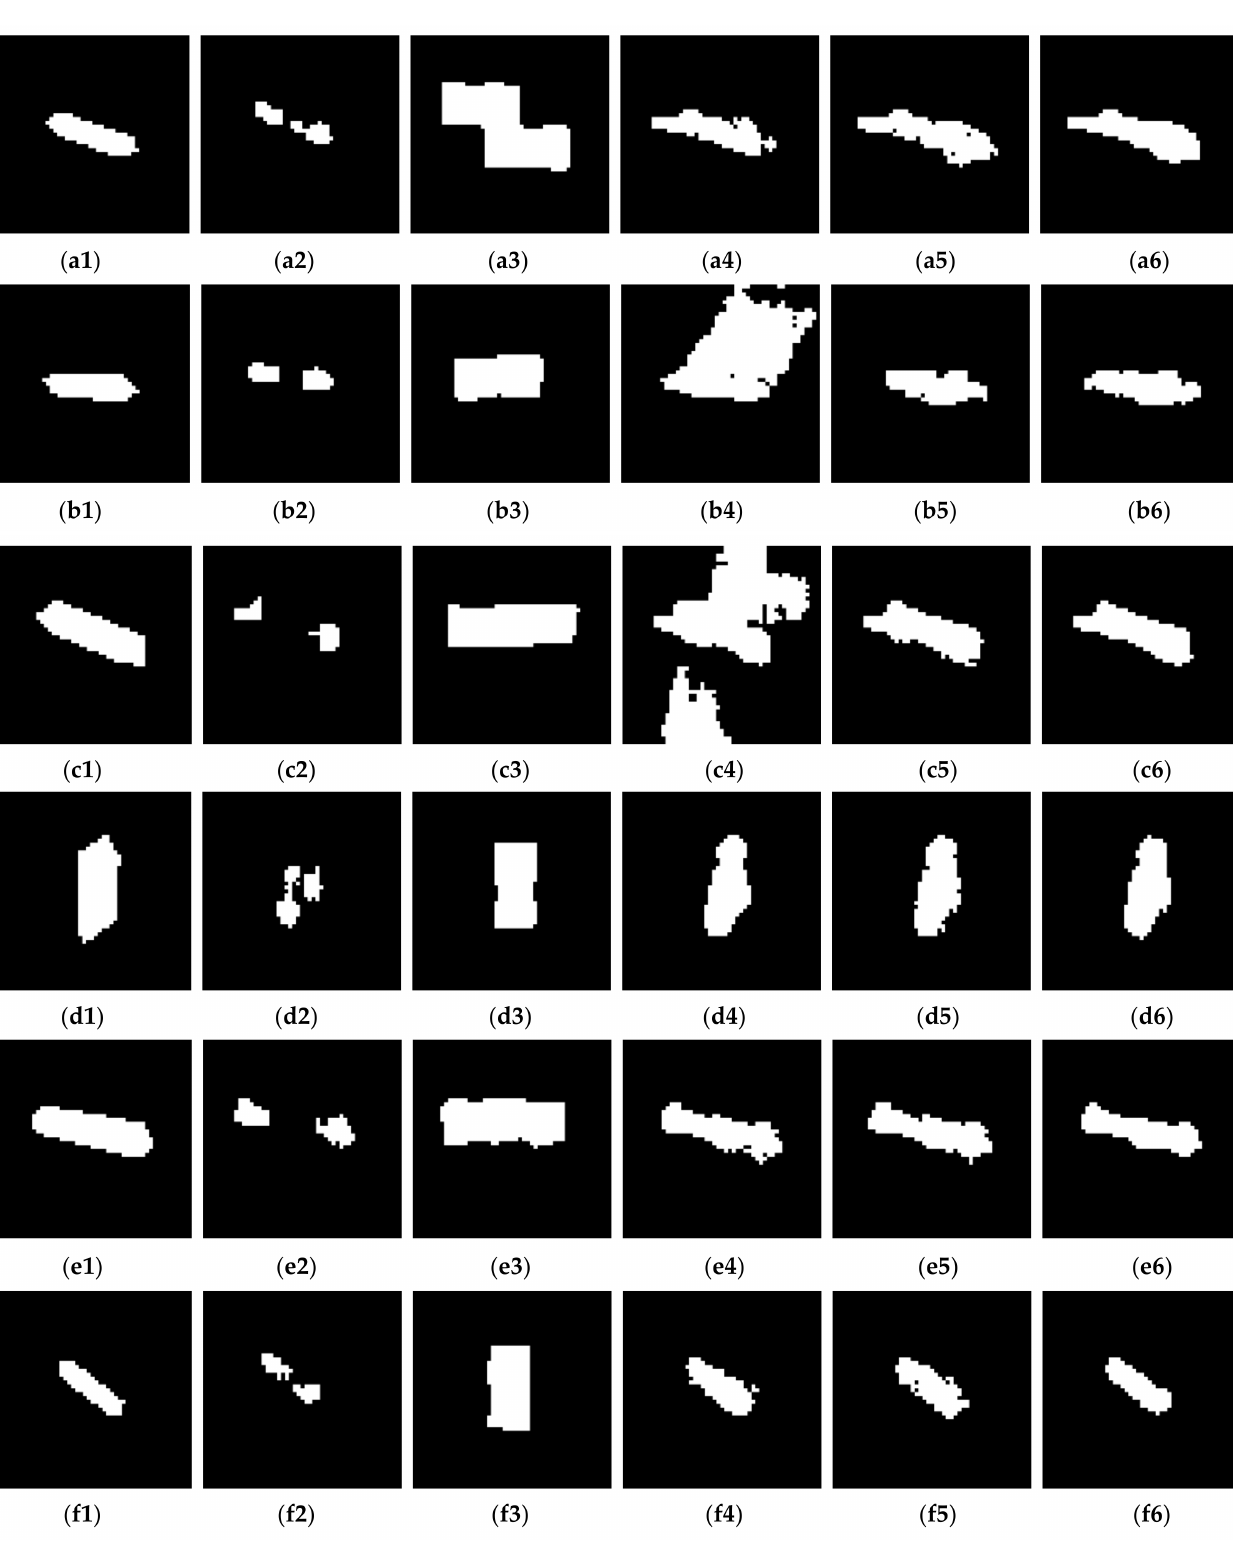
Figure 13. Detection results of ship targets. ( a1 – f1 ) Ground-truth images. ( a2 – f2 ) SO-CFAR. ( a3 – f3 ) SP. ( a4 – f4 ) T3 + SVM. ( a5 – f5 ) PCP + SVM. ( a6 – f6 ) Proposed